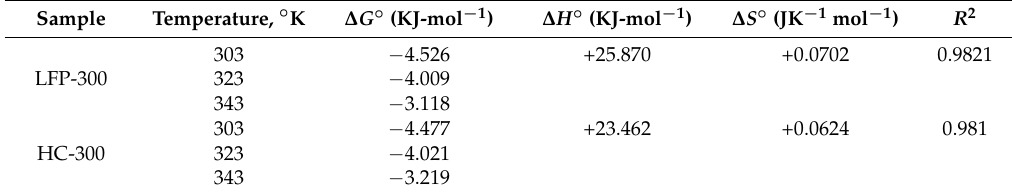
Table 5. Thermodynamic parameters of Pb (II) adsorption for LFP-300 and HC-300.